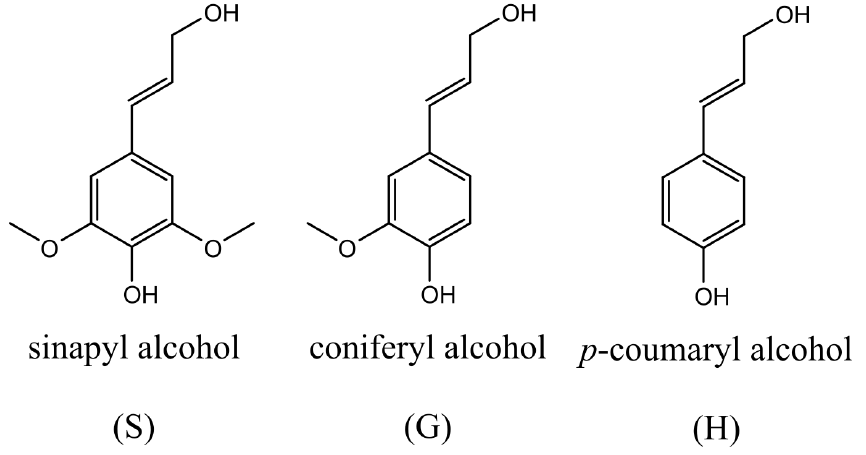
Figure 1. Sinapyl, coniferyl, and p-coumaryl alcohols, precursors of S, G, and H units, respectively. The lignin polymerization process leads to a variety of inter-unit linkages, includ- ing aryl ether bonds ( β - O -4, α - O -4, 4- O -5) and carbon-carbon linkages (5-5 (cid:48) , β -5, β -1, β – β ) [25,27]. The frequency of each type of linkage in lignin’s structure depends on the relative contribution of each monomer to the polymerization process. In native lignin, the most abundant dilignol linkage is the β - O -4 type (structure A, Figure 2), accounting for more than 50% of the interunit linkages in lignin structure [8,28]. Therefore, the β - O -4 content of isolated lignins strongly depends on the separation method used and the severity of the applied process conditions. The existence of various interunit linkages, high propensity for the formation of condensed structures when thermochemically processed, poor product selectivity, and ease of use as a solid fuel are the major barriers to the development of lignin-based biorefining technologies [28]. For these reasons, valorization of technical lignins requires detailed insight into the structure and composition impact of the type of plant and species, the delignification process, and the isolation method applied